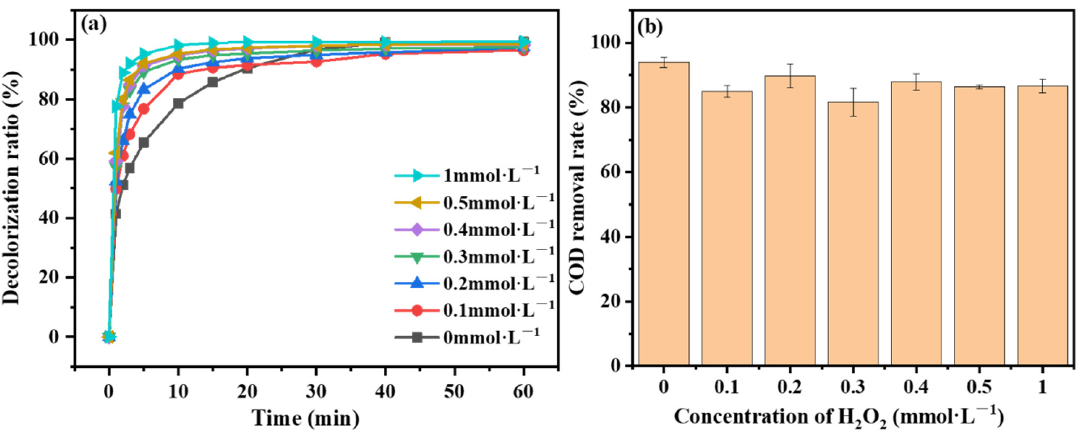
Figure 5. Effect of different H 2 O 2 concentrations on the ( a ) decolorization rate of ARG and ( b ) COD removal rate in the Fe 3+ /H 2 O 2 /CSPAC system (0.1 mmol/L FeCl 3 , 0–1 mmol/L H 2 O 2 , 100 mg/L ARG, 0.6 g/L CSPAC (75 μ m particle size), pH = 3).